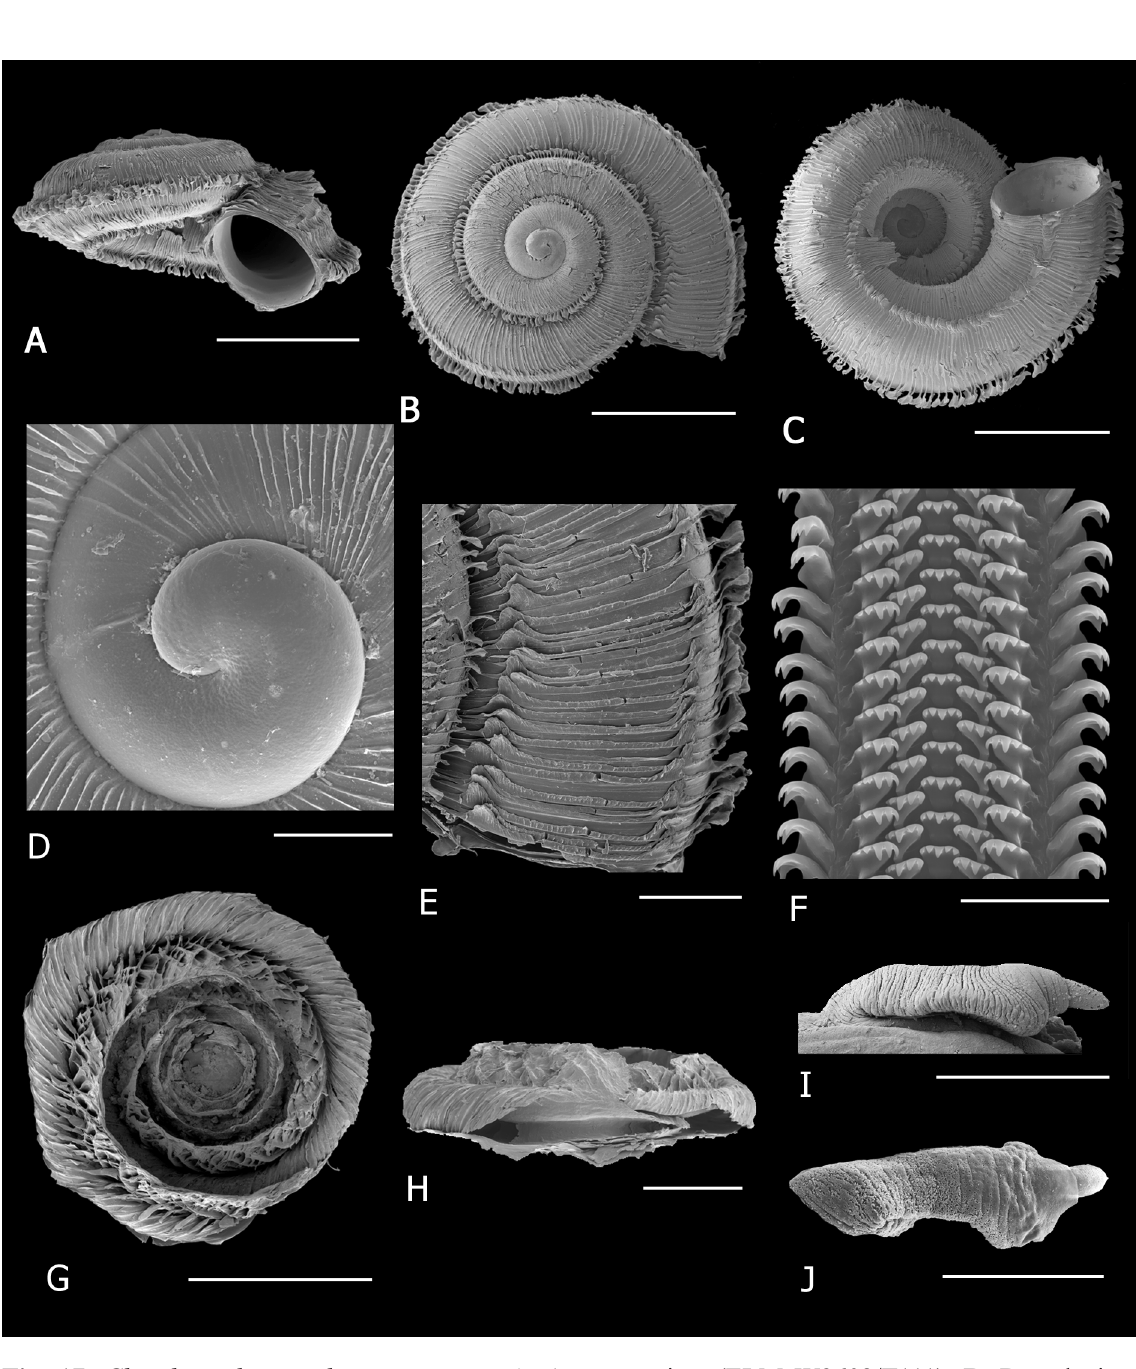
Fig. 17. Chondrocyclus pondoensis sp. nov. A . Aperture view (ELM W3602/T111). B . Dorsal view (ELM W3627/T114). C . Ventral view (ELM W3627/T114). D . Protoconch (NMSA W8733). E . Detail of axial lamellae of periostracum (ELM W3627/T114). F . Portion of radula (ELM W3627/T114). G–H . Operculum (ELM W3627/T114). I . Penis, lateral view (NMSA W7844/T4144). J . Penis, dorsal view (ELM W3627/T114). Scale bars: A–C = 2 mm; D = 200 µm; E, H = 500 µm; F = 50 µm; G, I–J = 1